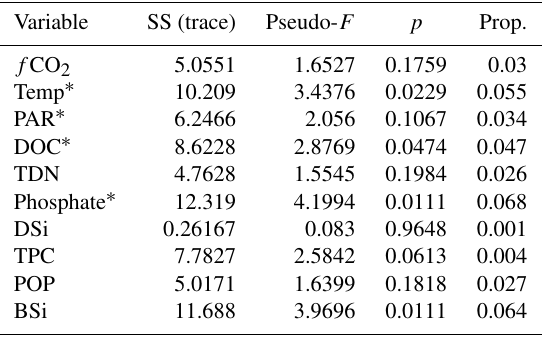
Table 4. Summary of a DistLM procedure for modelling the re- lationship between physicochemical variables and a resemblance matrix based on a multivariate assemblage comprising normalized data of bacterial protein production (BPP), areal primary production (PP) and community respiration (CR). Redundant physicochemical variables were removed prior to analysis. Therefore, PON and pH were excluded from the subsequent analysis due to high correlations ( r s >0.9) to TPC and f CO 2